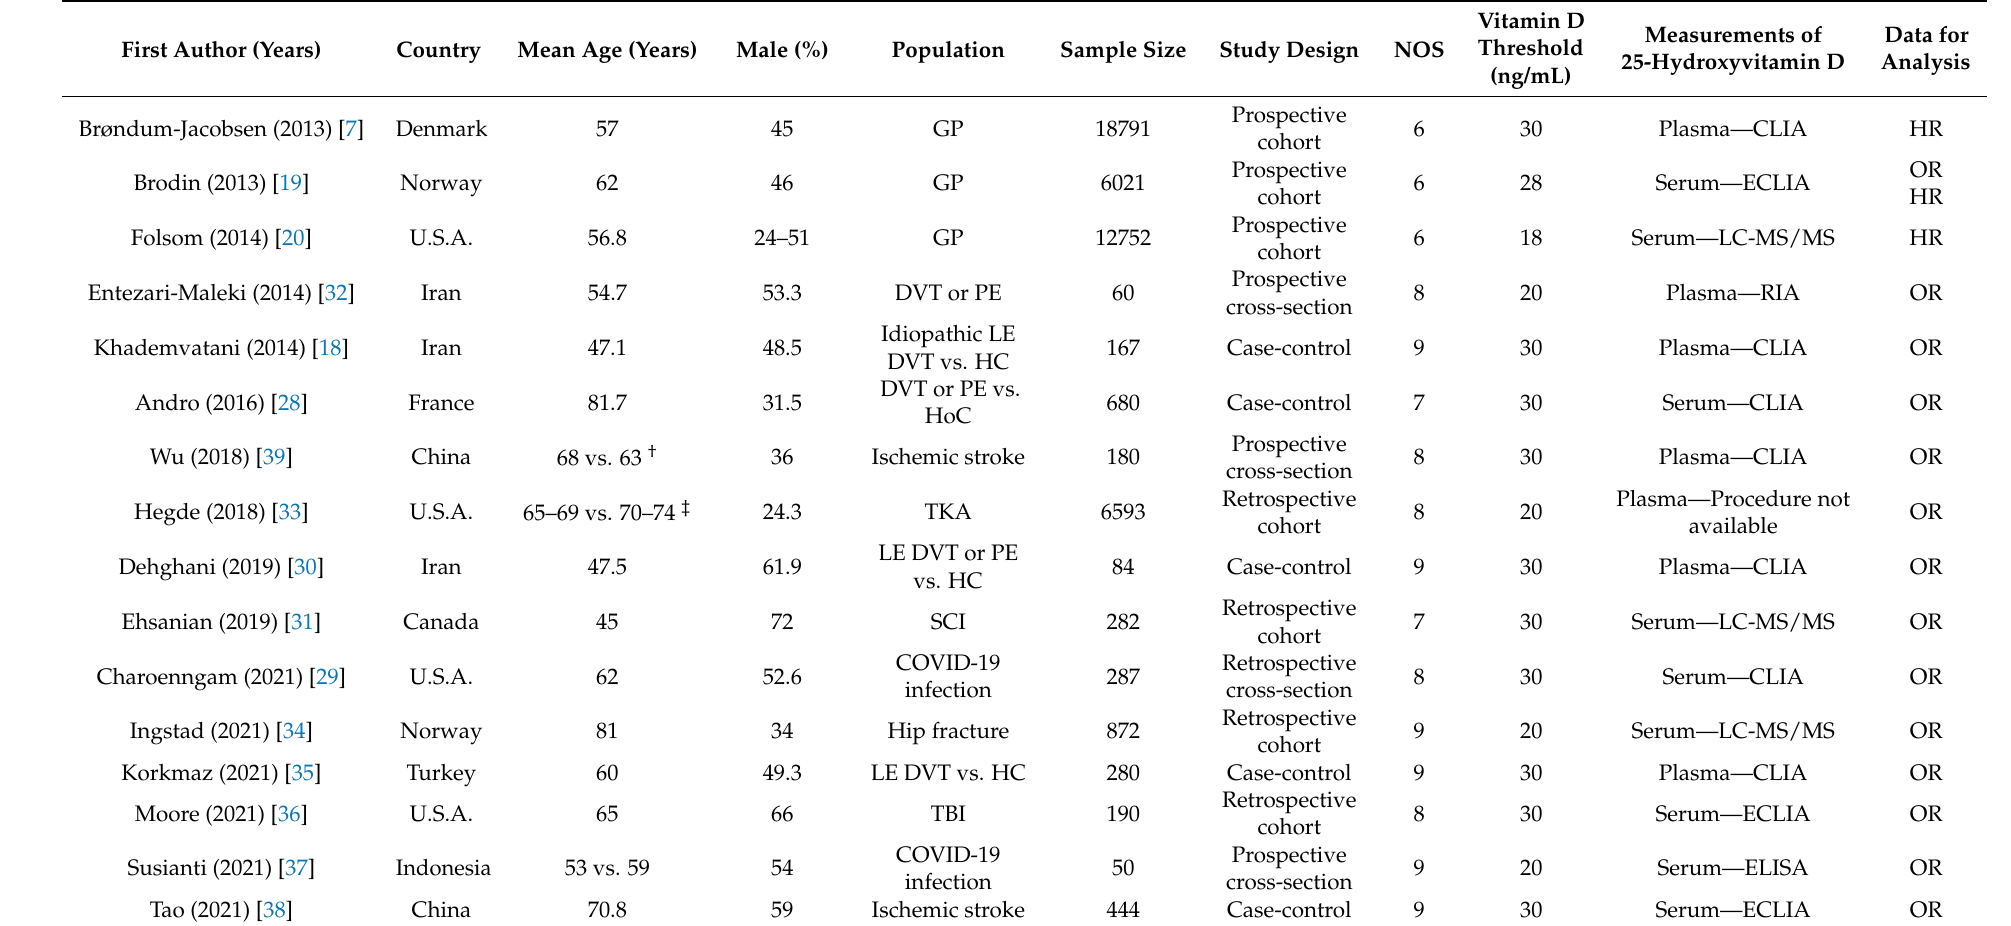
Table 1. Characteristics of included studies (n =